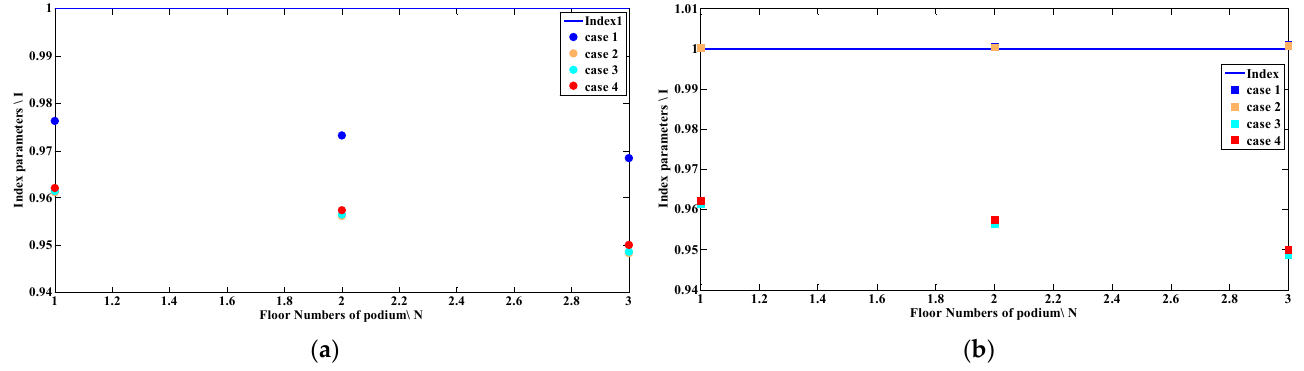
Figure 15. ( a ) Control effect of displacement response of podium; ( b ) control effect of absolute acceleration response of podium .